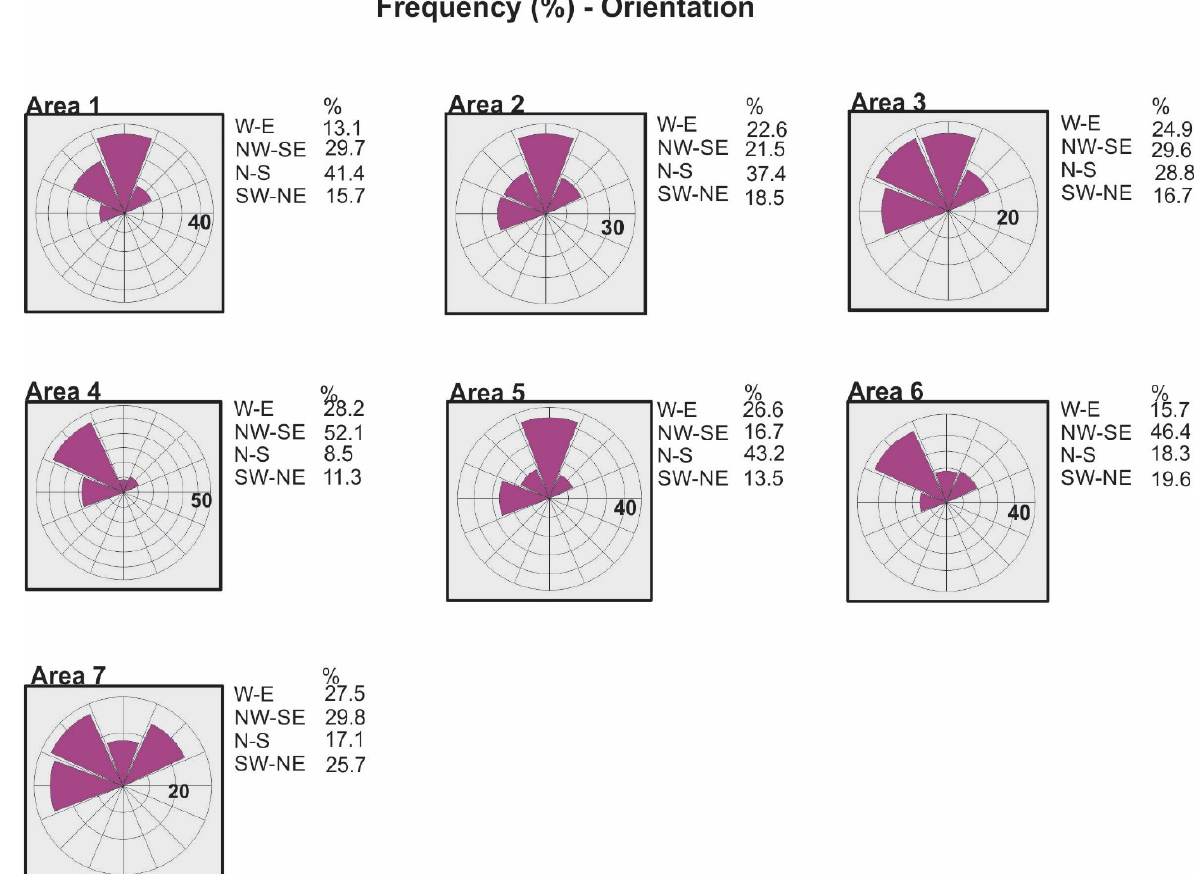
Figure 8. Radial histograms depicting the orientation of the lineaments hand mapped across the seven subset areas, with related statistics. A N–S and NW–SE trend of the newly mapped linear features predominates. Details about the mapping for the other subsets can be found in the Supplementary Data (panel Figures S17–S19).